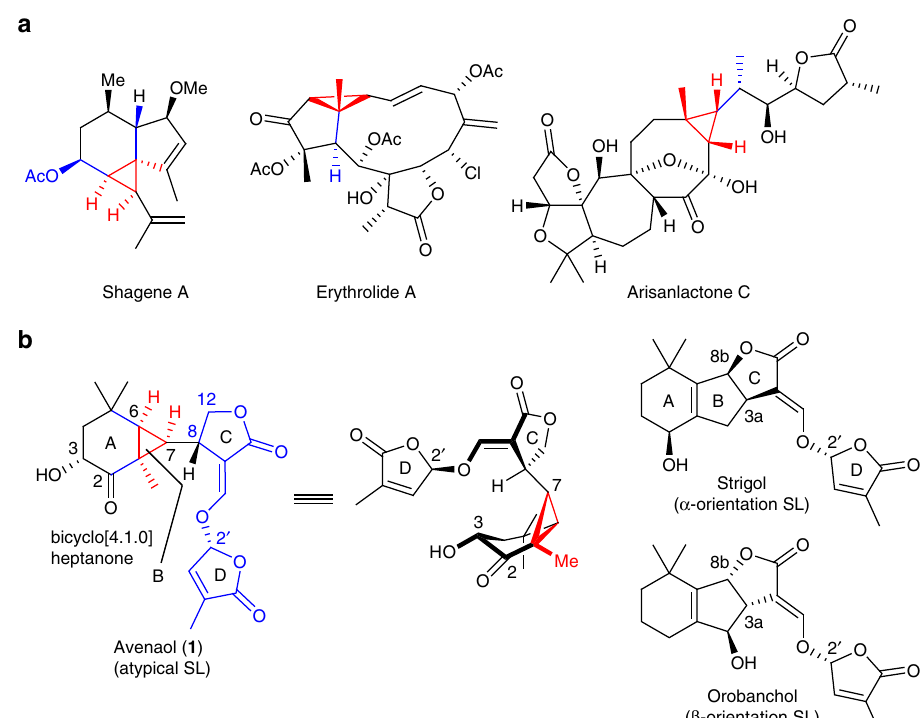
Fig. 1 Natural products containing all- cis -substituted cyclopropanes. a Various natural products containing an all- cis -substituted cyclopropane, all of which have been reported to show intriguing biological activities. b The structures of avenaol and two typical strigolactones. The major differences between these compounds include the AB ring carbon skeleton and the connectivity between the BC rings. The construction of the AB ring of avenaol represents a challenging